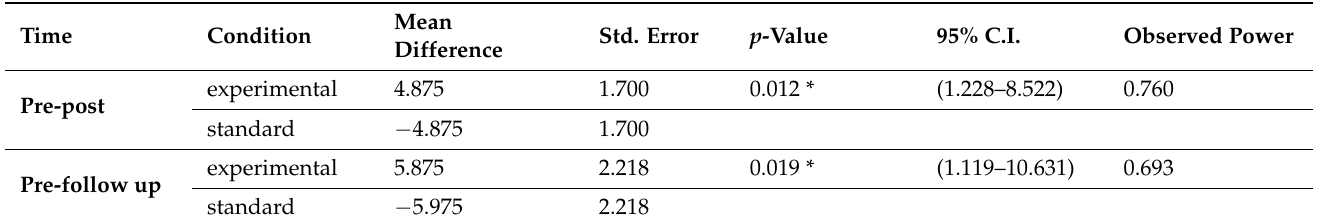
Table 4. ANOVA table demonstrating increases in knowledge on how to accurately clean a